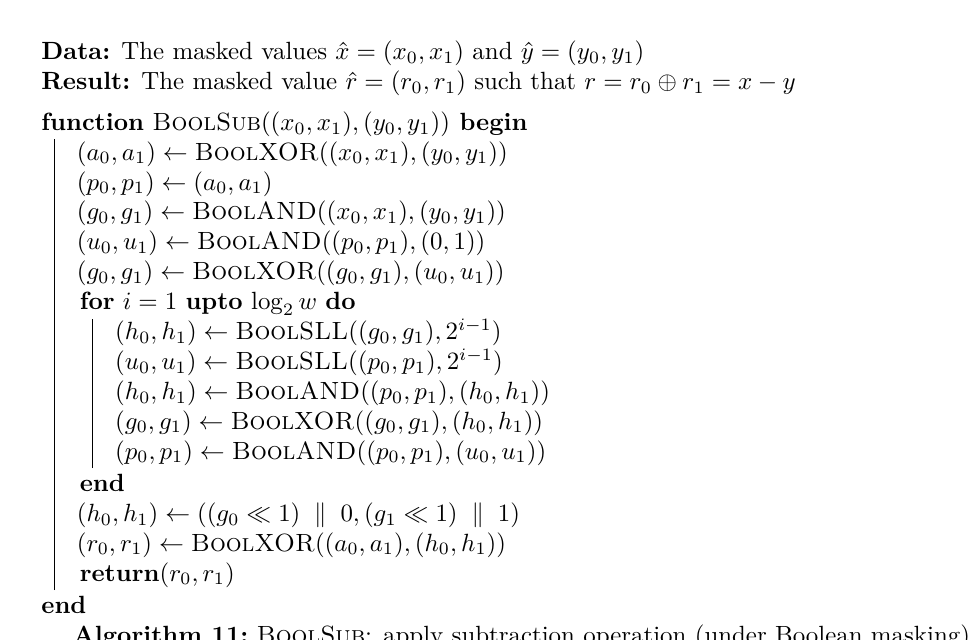
Algorithm 10: BoolAdd : apply addition operation (under Boolean masking).